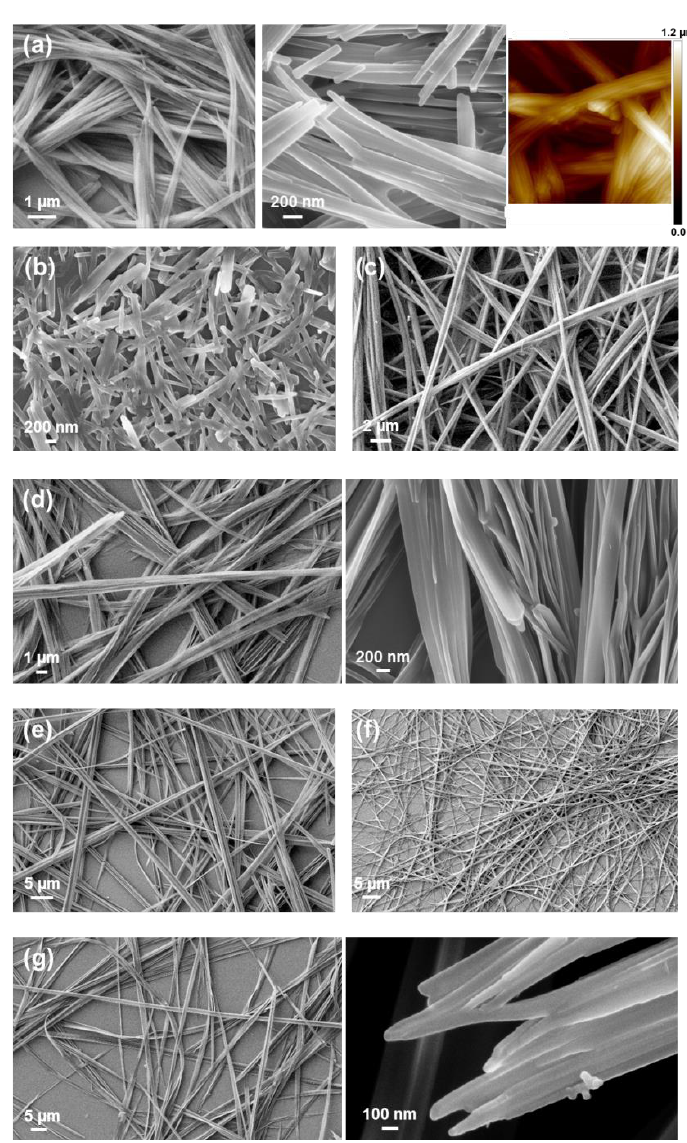
Figure 15. ( a – g ) SEM and ( a ) AFM (7 × 7 µm 2 ) images of the structures obtained from Fmoc-F * F-OFm solutions in ( a ) 4:6 HFIP:water (2 mg/mL), ( b ) 1:9 HFIP:water (0.5 mg/mL), ( c ) 4:1 HFIP:water (4 mg/mL), ( d ) 4:6 HFIP:MeOH (2 mg/mL), ( e ) 4:6 HFIP: i PrOH (2 mg/mL), ( f ) 1:19 HFIP: i PrOH (0.25 mg/mL), and ( g ) 4:6 HFIP:acetone (2 mg/mL) mixtures.